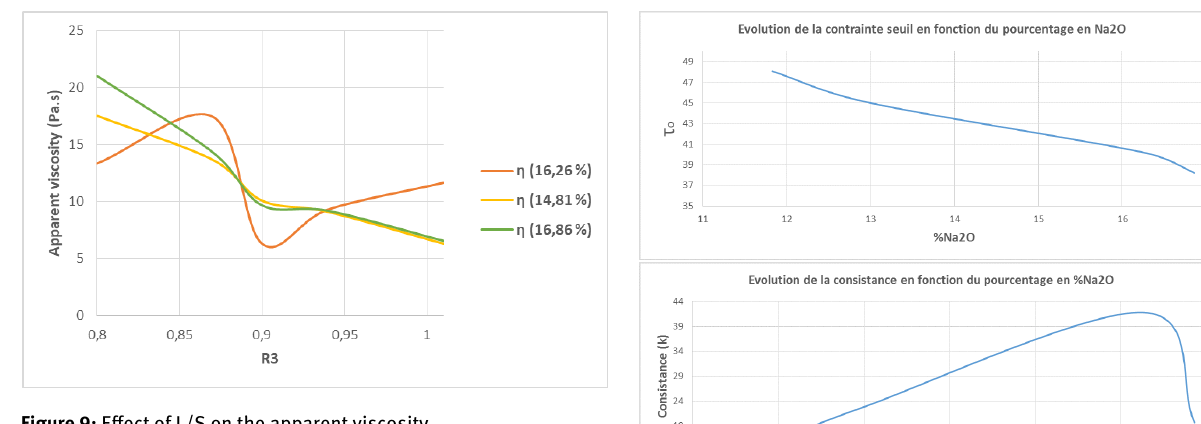
cording to the ratio R 3 . The appearance of the peak at the level of P = 16.26 and R 3 = 0.94 is still valid for different shear rates (Figure 8), these modeling parameters repre- sent a critical point characterizing the material.